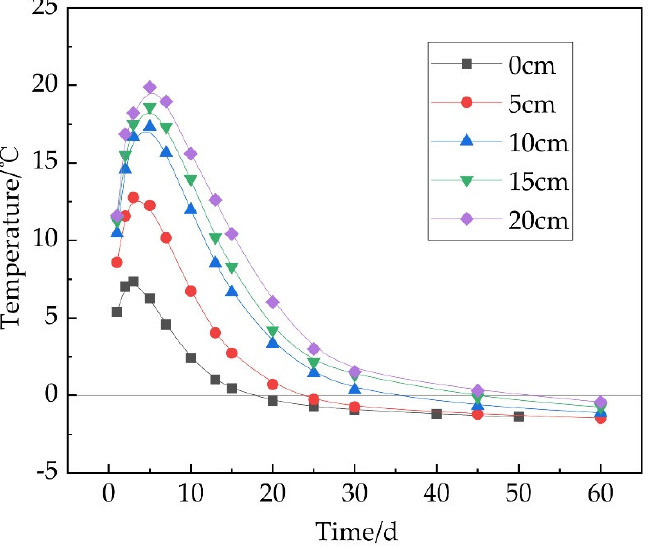
Figure 8. 0–50 d temperature of pile body with different insulation layer thickness.